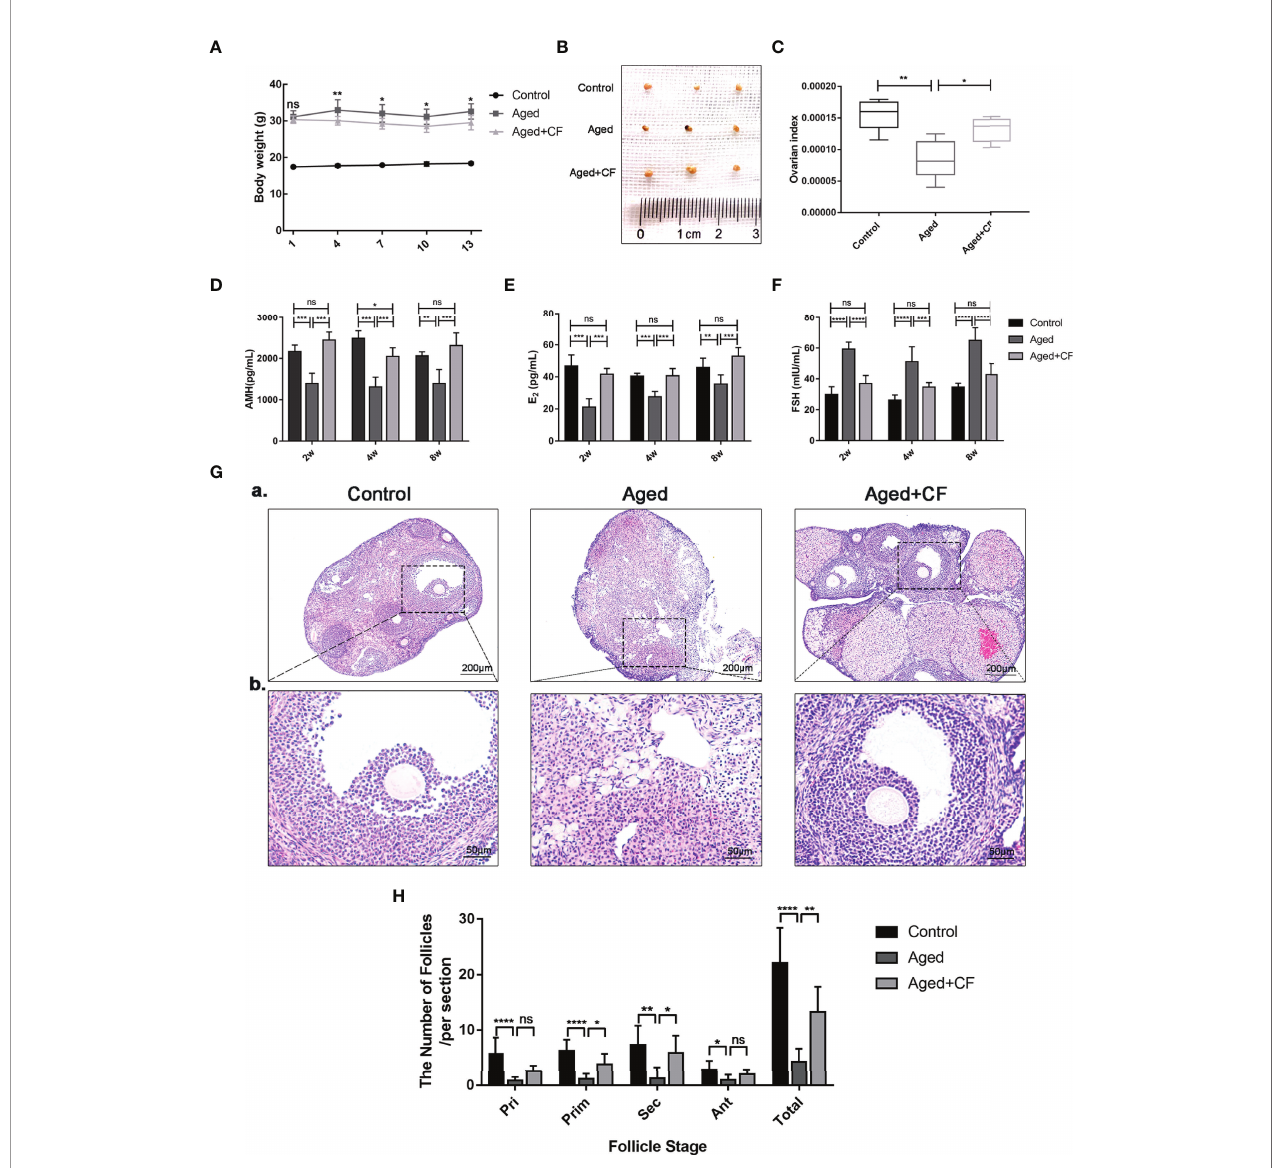
FIGURE 1 | Cell-free fat extract (CEFFE) improves ovarian function in aged mice. (A) The body weight of mice was monitored every two days during the treatment duration (n=5). (B) Gross morphologies of dissected ovaries from different groups (n=3). (C) The index of ovaries (the ratio of ovarian weight to body weight) in each group were compared and analyzed (n=5). (D – F) Serum AMH, E 2 , and FSH secretion levels were measured via ELISA every two weeks until 8 weeks after treatment (n=3-5). (G) Representative ovary morphology (a) and follicle morphology (b) of Hematoxylin and Eosin staining from each group were captured. Scale bar=200 m m or 50 m m. (H) The number of different stage follicles was calculated and analyzed (n=7). Pri, primordial follicles; Prim, primary follicles; Sec, secondary follicles; Ant, Antral follicles; Atr, atretic follicles; Total, The total number of health follicles (including primordial, primary, secondary and antral follicles). Data are represented as mean ± SD, ns: P > 0.05, * P < 0.05, ** P < 0.01, *** P < 0.001, and **** P <